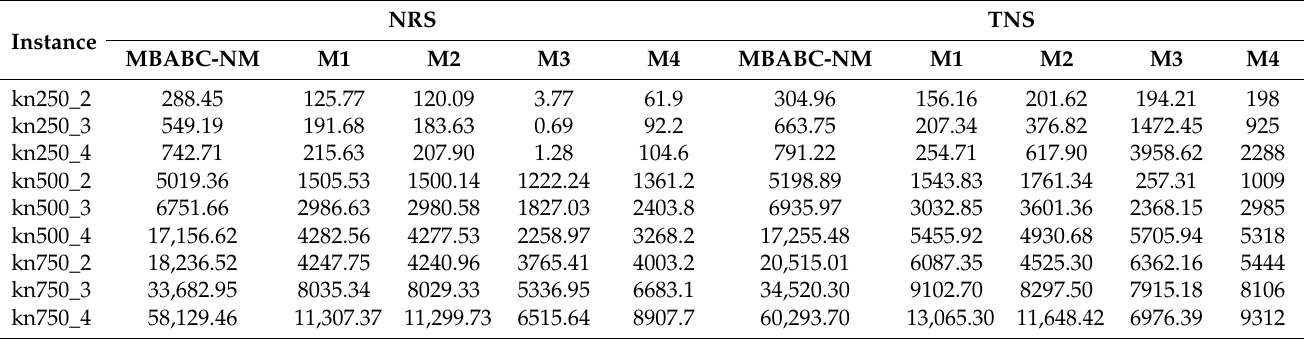
Table 7. Experimental results of MKP dataset in terms of NRS and TNS.